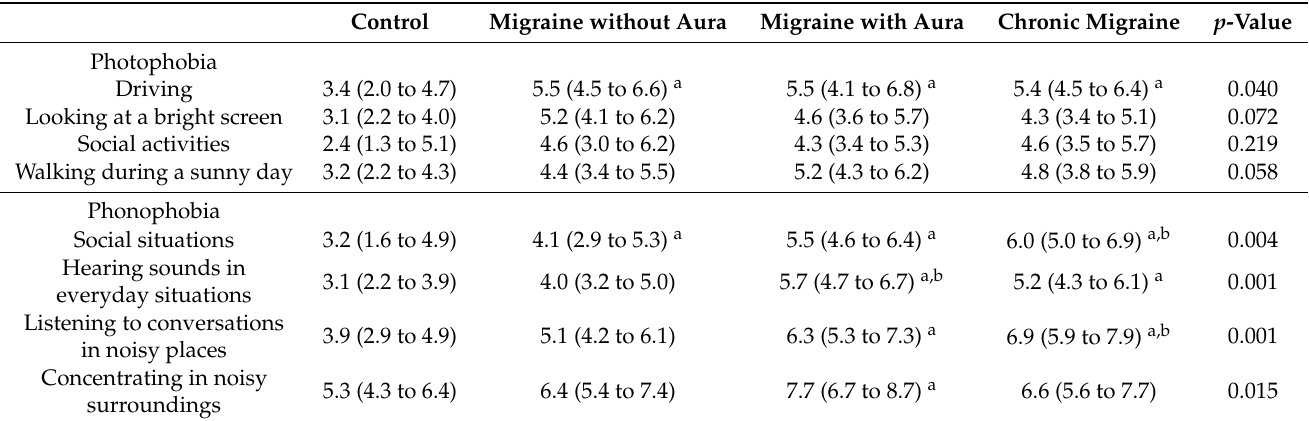
Table 3. Interictal photophobia and phonophobia during daily activities (mean and 95% confidence interval). Control Migraine without Aura Migraine with Aura Chronic Migraine p -Value